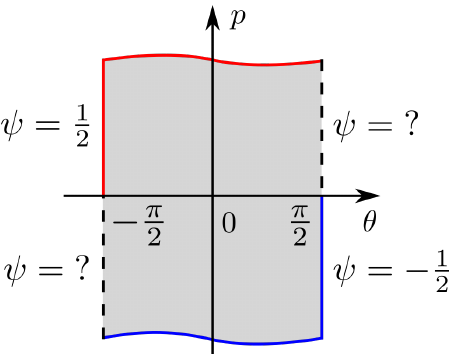
Figure 2: Boundary conditions (11) to Eq. (9) for the function ψ ( θ , p ) . It should be obtained inside the shaded region and on two dashed segments of the